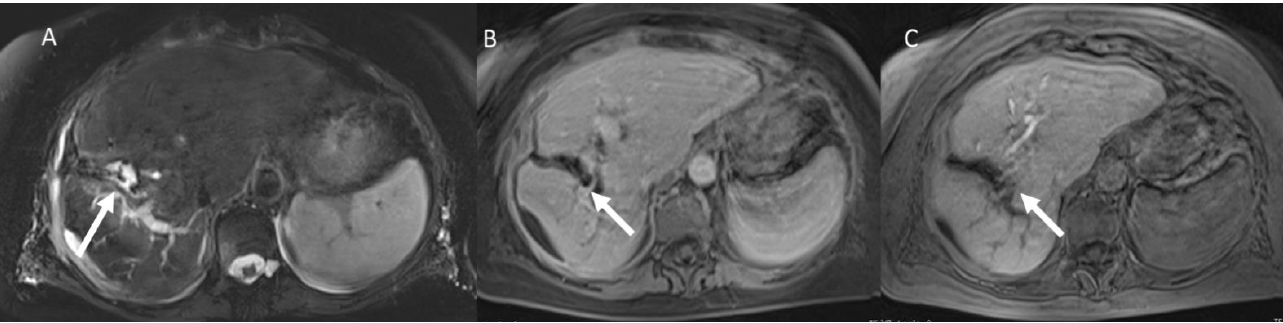
Figure 6. The same patient as Figure 5. MRI assessment. ( A ) SPACE T2-weighted sequence, ( B ): portal phase of contrast study and ( C ) EOB-phase after 1-month, arrow shows biloma and no bile leak.